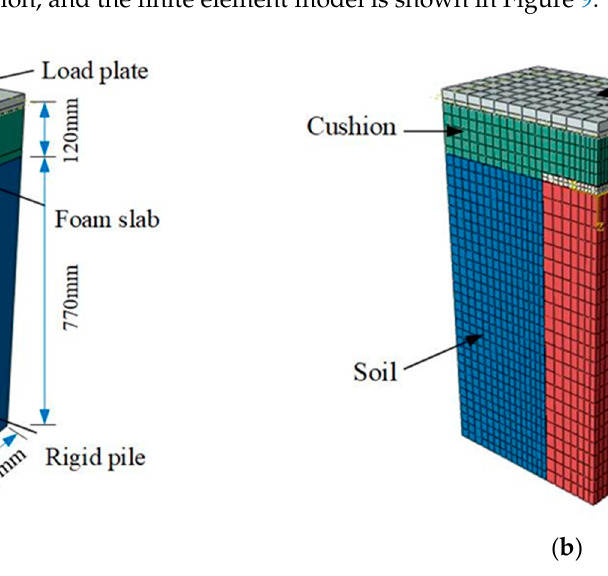
Figure 9. Finite element model of indoor tests: ( a ) model with size; ( b ) mesh.